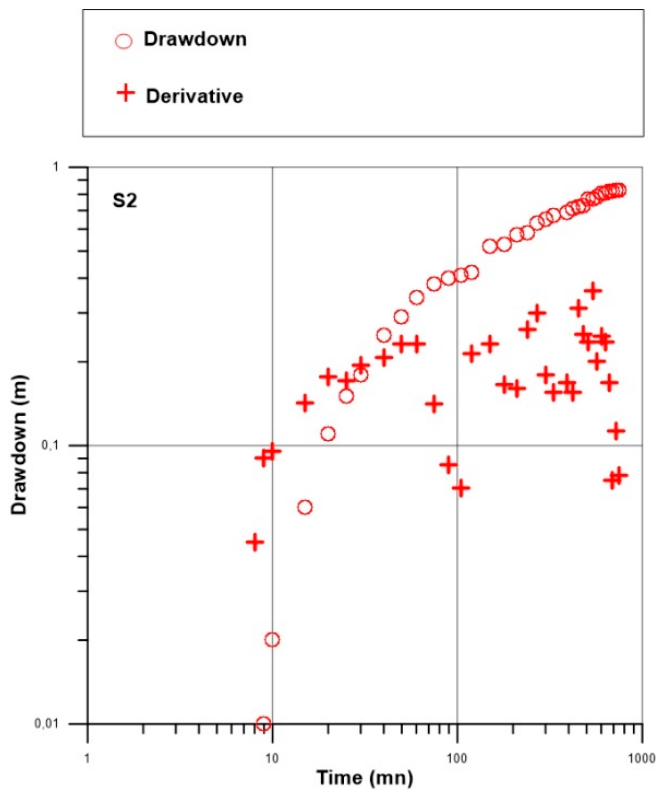
Figure 9. Observed drawdown and its derivative (without smoothing) in observation well S2.